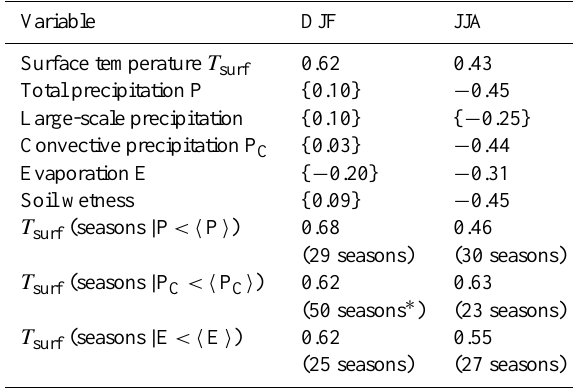
Table 3. Correlation r of δ 18 O in precipitation with meteorologi- cal variables at Kourovka according to model results for the period